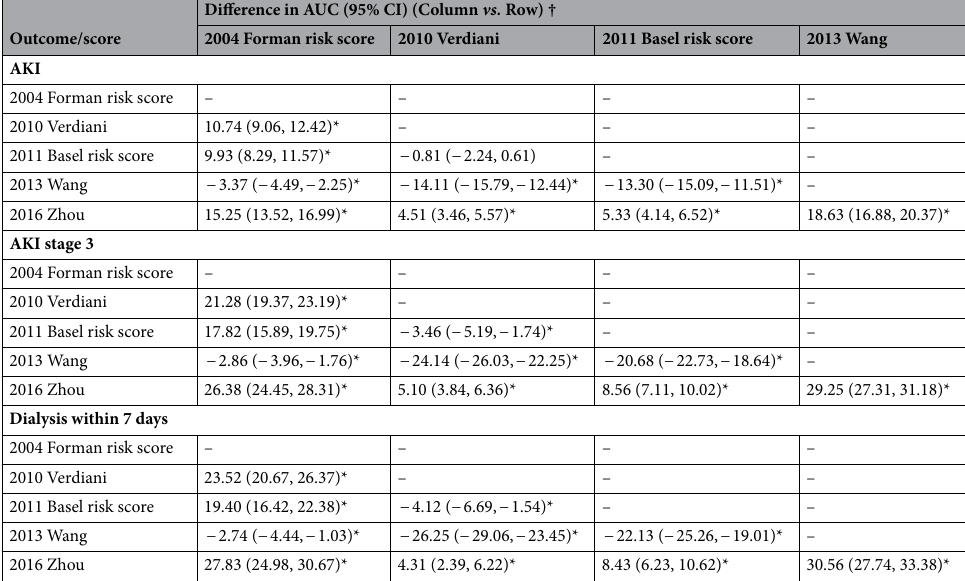
Table 4. Pairwise comparisons of area under the receiver operating characteristic curve between the prediction models. *Indicates P < 0.05; † DeLong’s test.